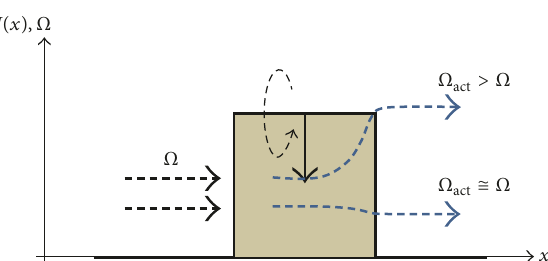
Figure 1: Schematic illustration of the system’s dynamics. For most energies activation occurs; that is, Ω energies, that is, Ω = Ω 𝑚 , activation is suppressed and then Ω Ω